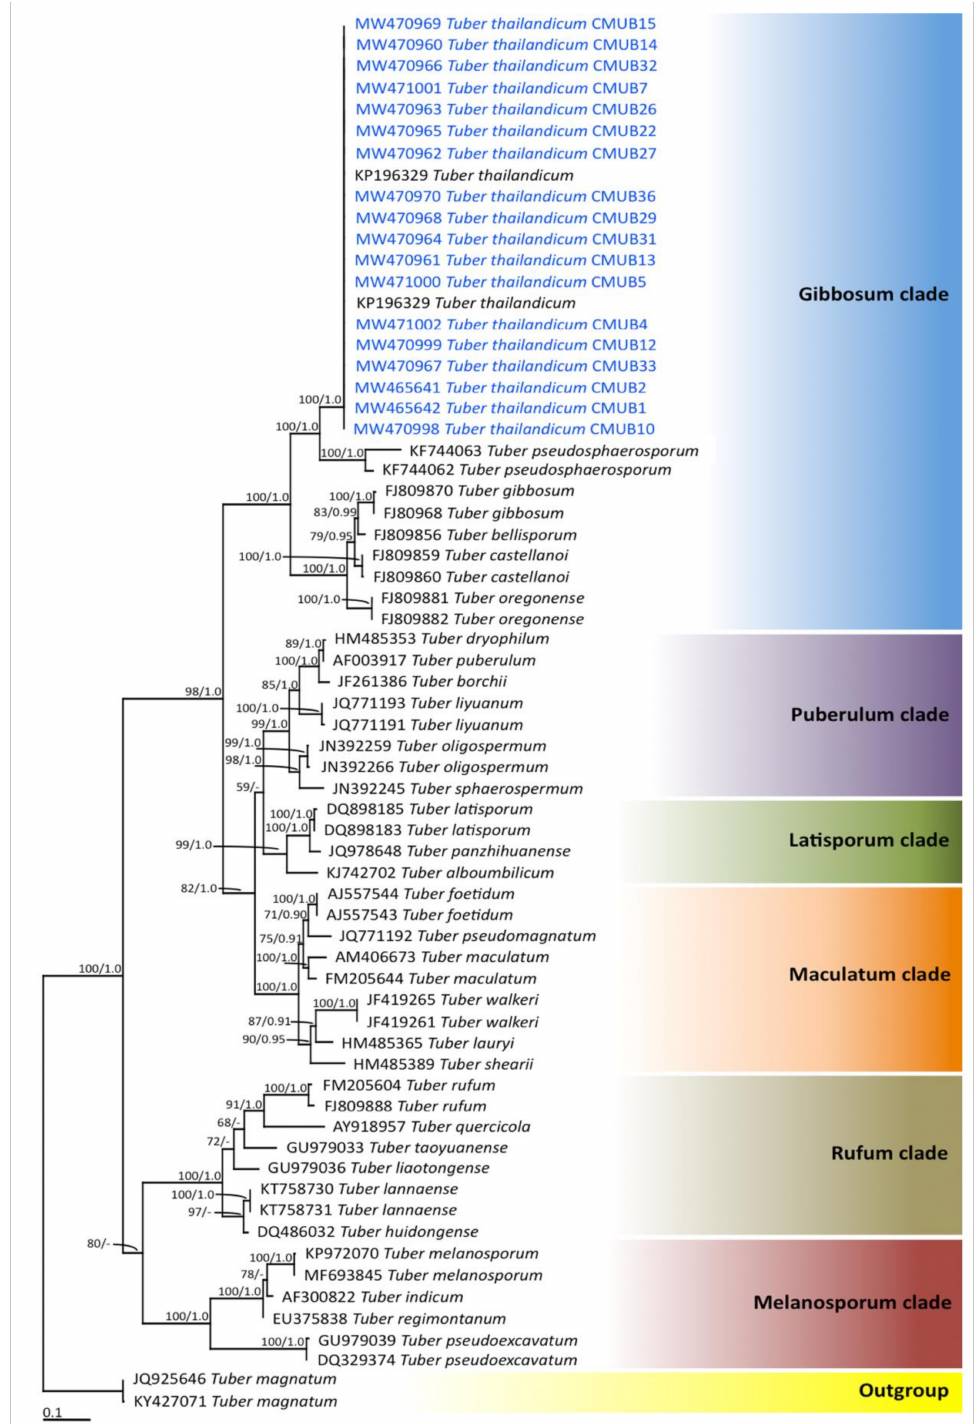
Figure 5. Phylogram derived from the maximum likelihood tree revealed by RAxML from an analysis of an ITS sequence of 66 taxa. Tuber magnatum was used as outgroup. The numbers above the branches represent Bootstrap support (BS) ( left ) and PP ( right ). Only BS values ≥ 70% and PP ≥ 0.90 are shown. “-” indicates a value of BS and PP of less than 70% and 0.90, respectively. The scale bar represents the expected number of nucleotide substitutions per site. Sequences obtained in this study are in